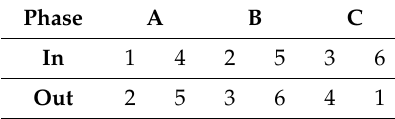
Table 2. The winding figuration of the 6 / 5 FSPM.